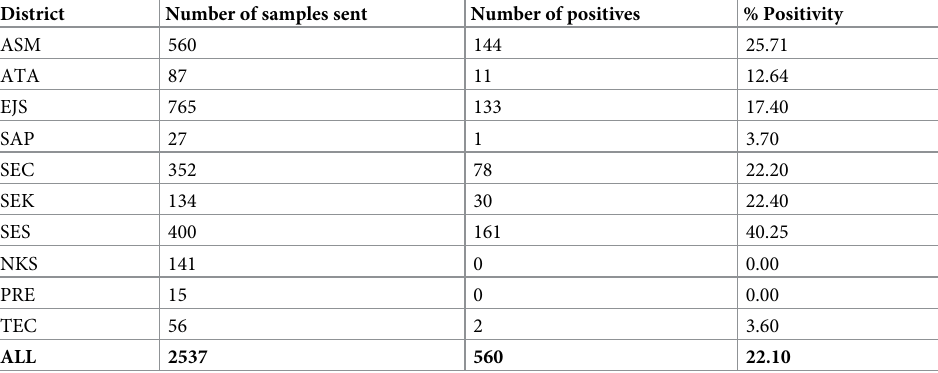
Table 2. Positivity rate of samples